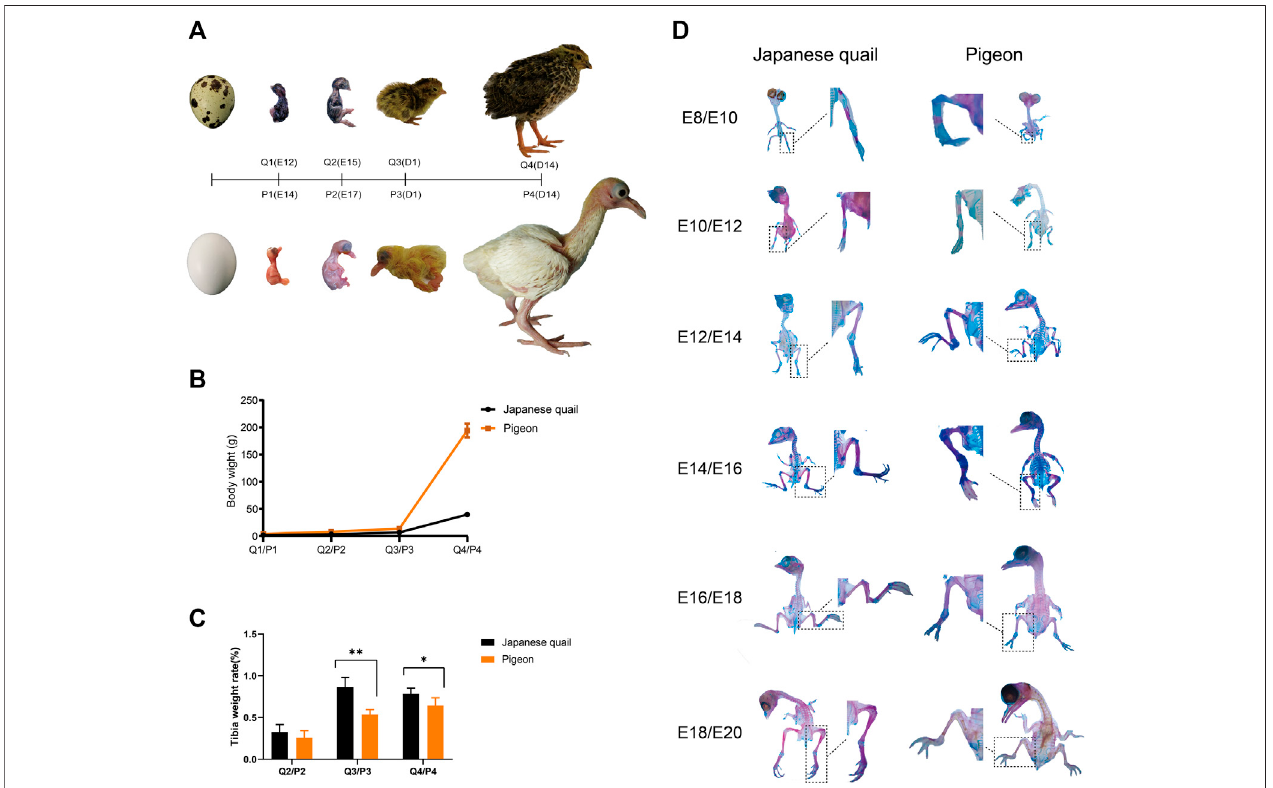
FIGURE 1 | The development of pigeons and quails in the embryonic period and the early phase post-hatching. (A) The ontogeny of quail and pigeon before and after hatching. (B) The change of bodyweight of quail and pigeon in the four growth stages. The error bars on the graphs represent std. dev. (C) The change of tibia weight rate ofquail and pigeon in the four growth stages. “ pp ” means the difference is signi fi cant at the 0.01 level, “ p ” means the difference is signi fi cant at the 0.05 level. The error bars on the graphs represent std. dev. (D) Comparison ofquail and pigeon skeletal staining at all sixtime points during the embryonic period. Q: quail, P: